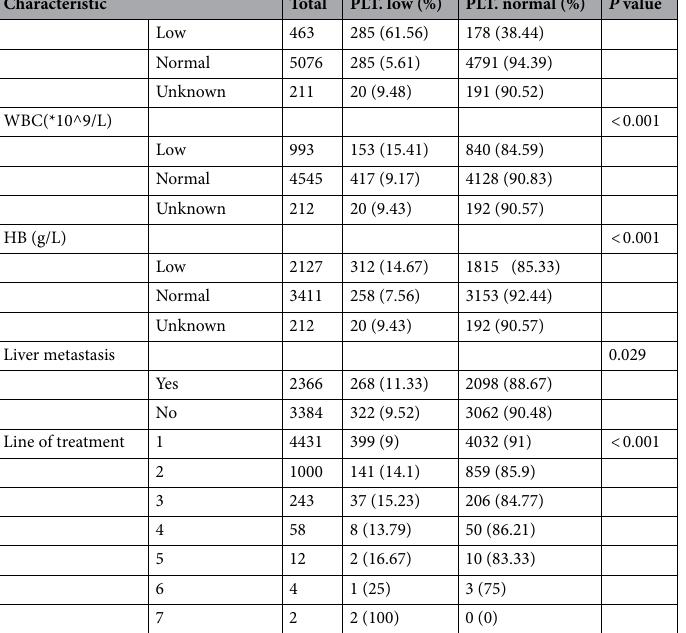
Table 2. Clinical characteristics based on chemotherapy